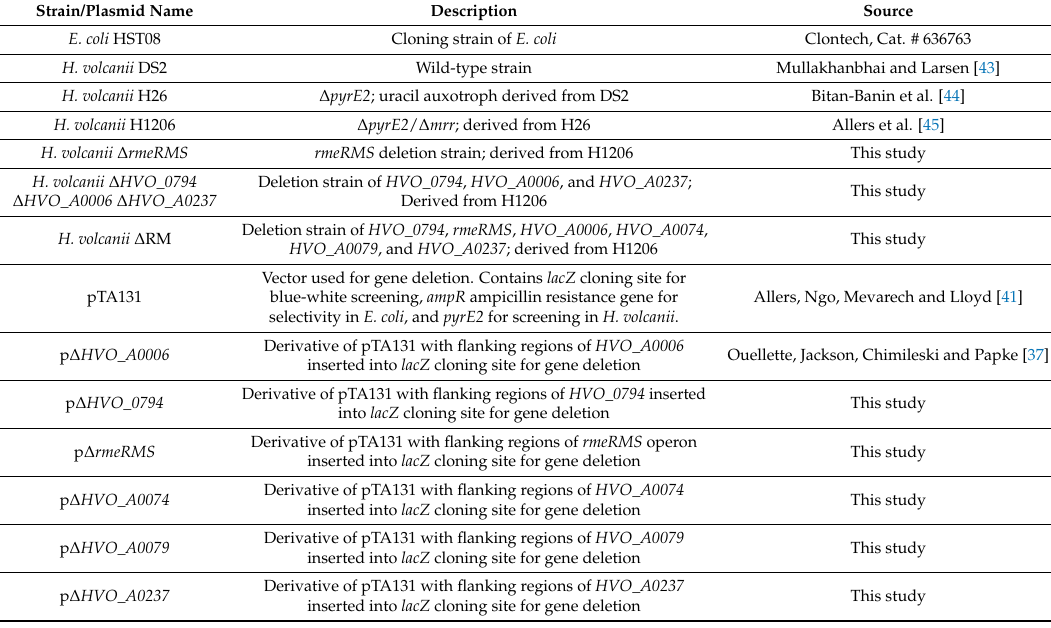
Table 1. Strains and plasmids used in this